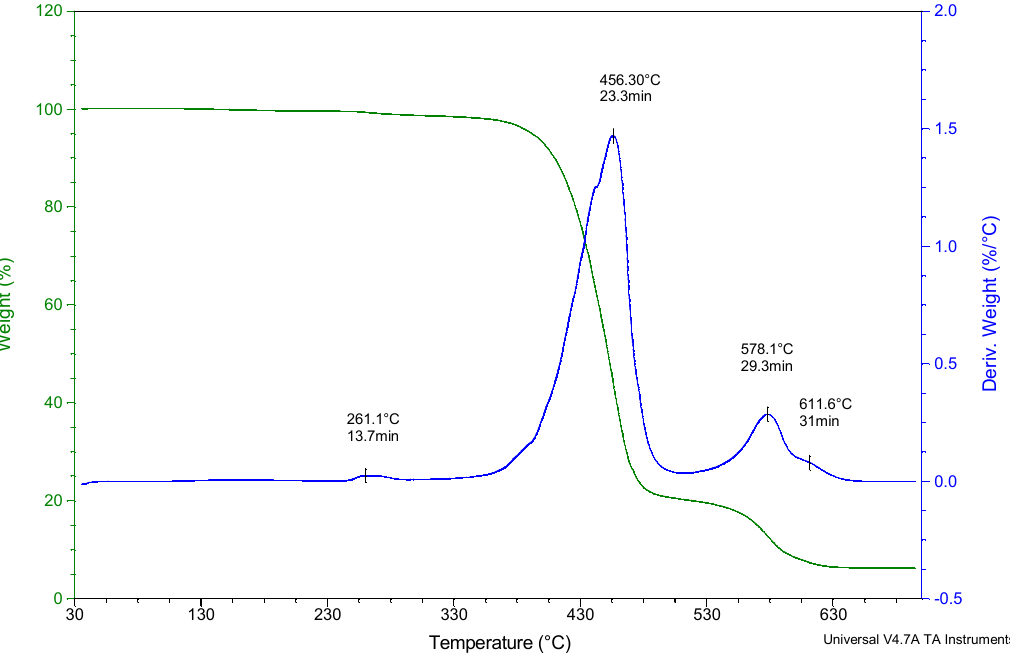
Figure 8. TG and DTG curves of PET modified with C15A (0.5%) with marked FTIR analysis points.